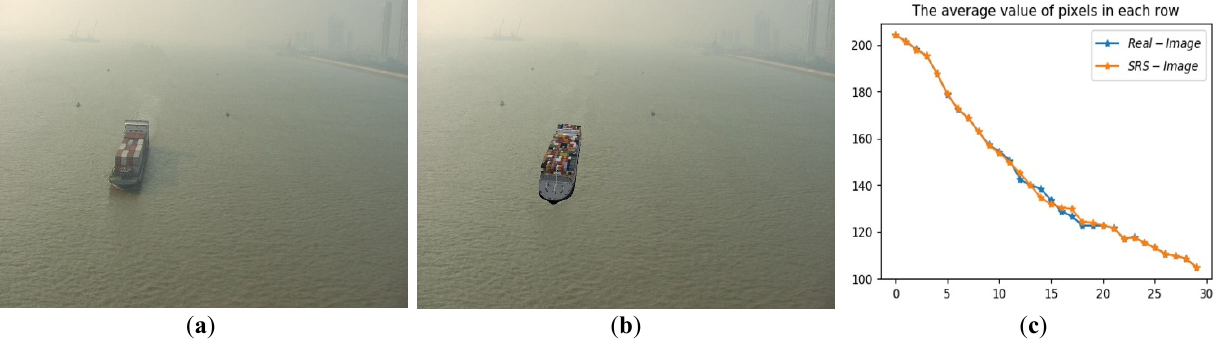
Figure 13. Difference between the SRS image and the real ship image: ( a ) the real ship image; ( b ) SRS images; ( c ) contrast curve.